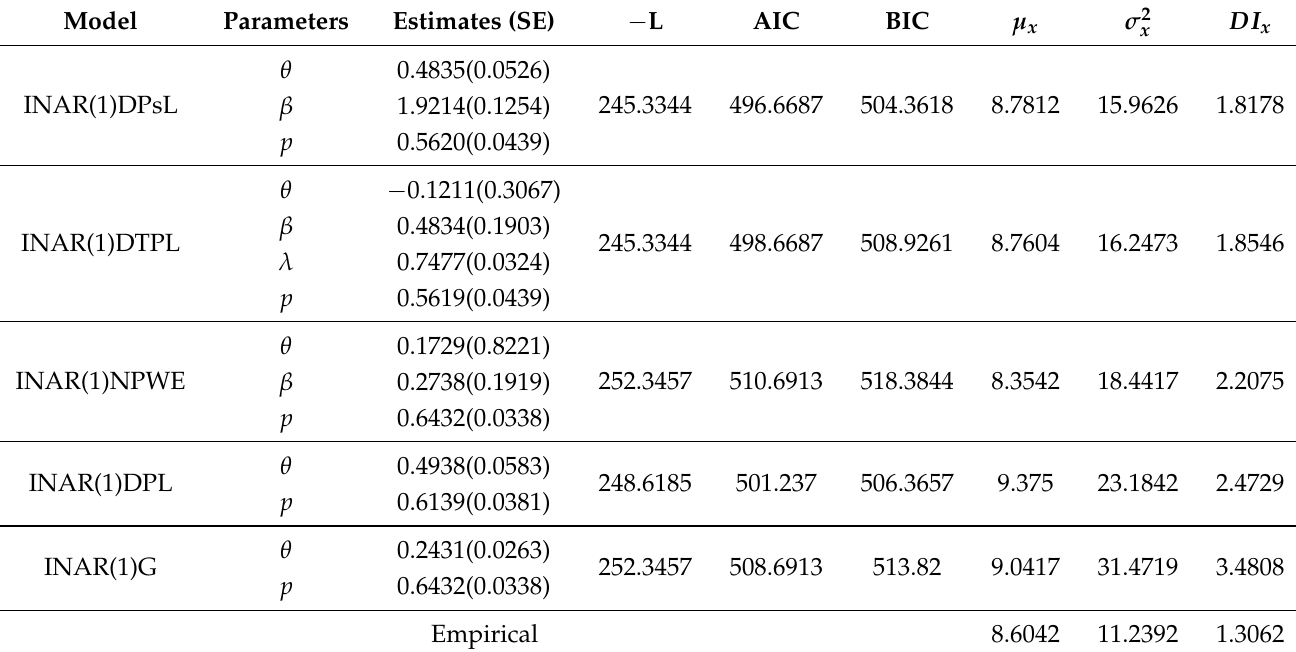
Table 13. The estimates and modelling adequacy statistics of the fitted distributions for the number of claims dataset.